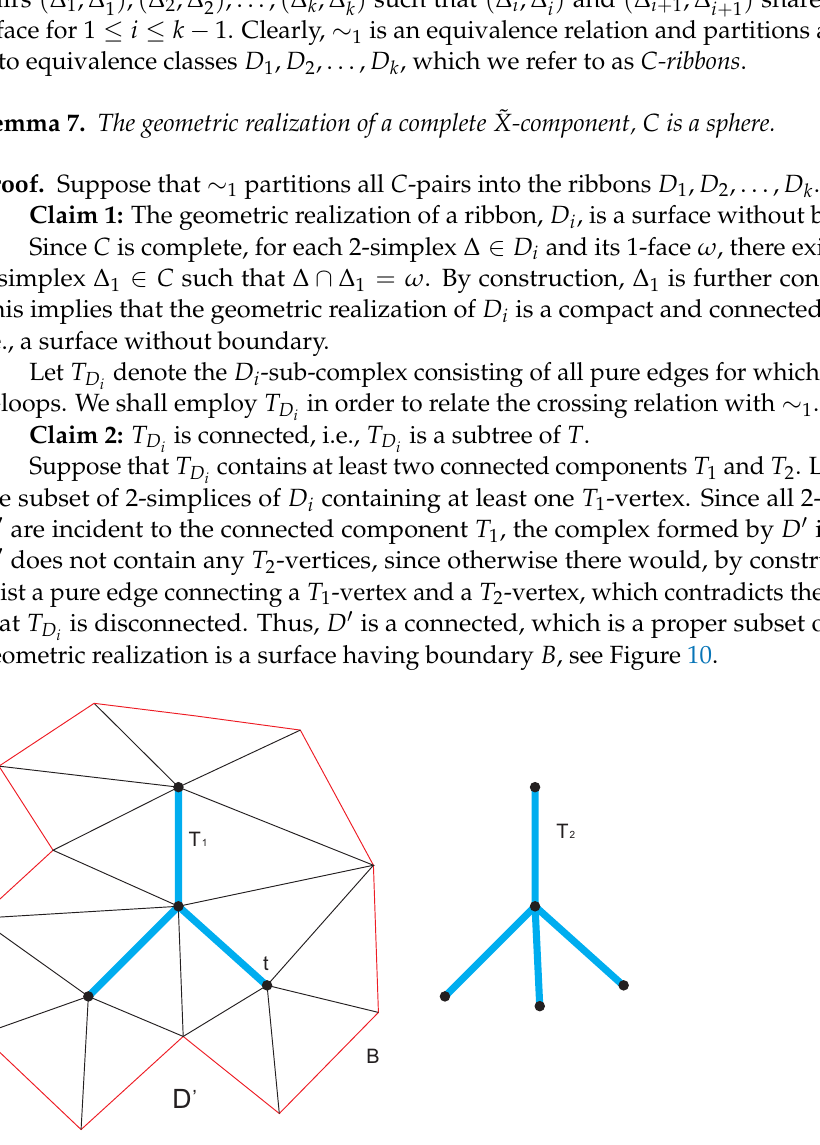
Figure 10. The boundary of D (cid:48) . The trees T 1 and T 2 (blue) represent the two connected components of T D . The sub-complex D (cid:48) is formed by 2-simplices of D i containing at least one T 1 -vertex. Then i the boundary B of D (cid:48) (red) consists of only S